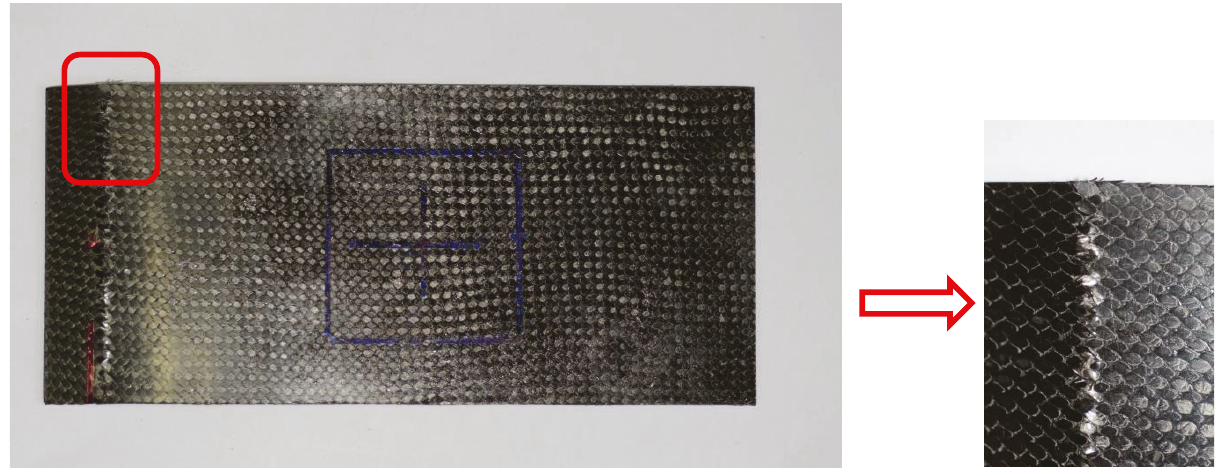
Figure 14: Final deformation and damage of target in test